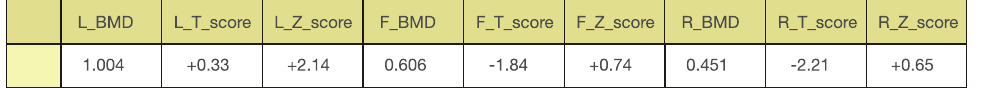
Figure 2. Unstructured pattern of a bone mineral density result in PACS-database was processed using a regular expression search. Lumbar BMD, T-score, Z-score, femur BMD, T-score, Z-score, radius BMD, T-score, and Z-score were extracted,